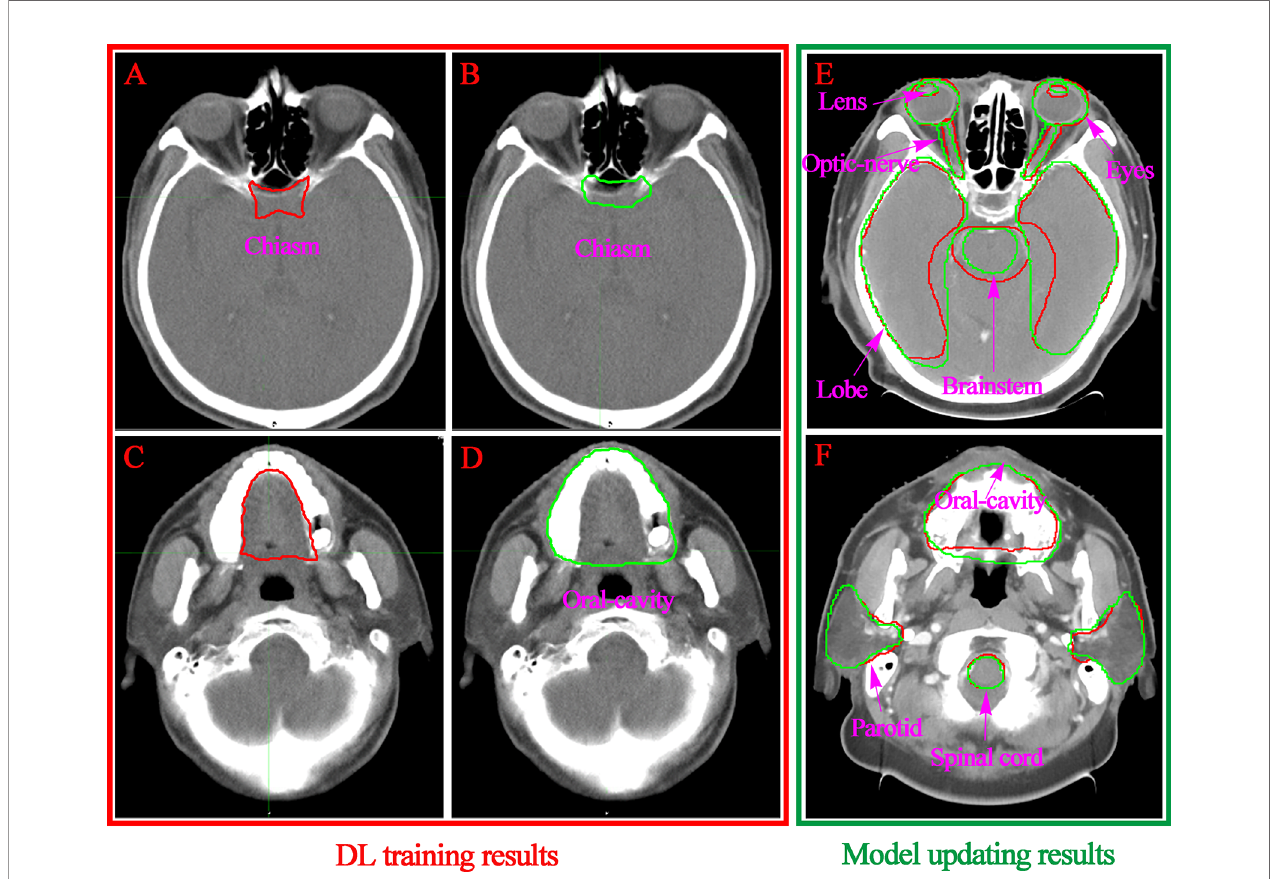
FIGURE 5 | Visualization of the convolution neural network-based segmentation results of the chiasm (A, B) and oral cavity (C, D) . The DL performance of the OARs with model updating are listed in the right column (E, F) . The ground truth segmentations are depicted in red, and the auto segmentations are depicted in